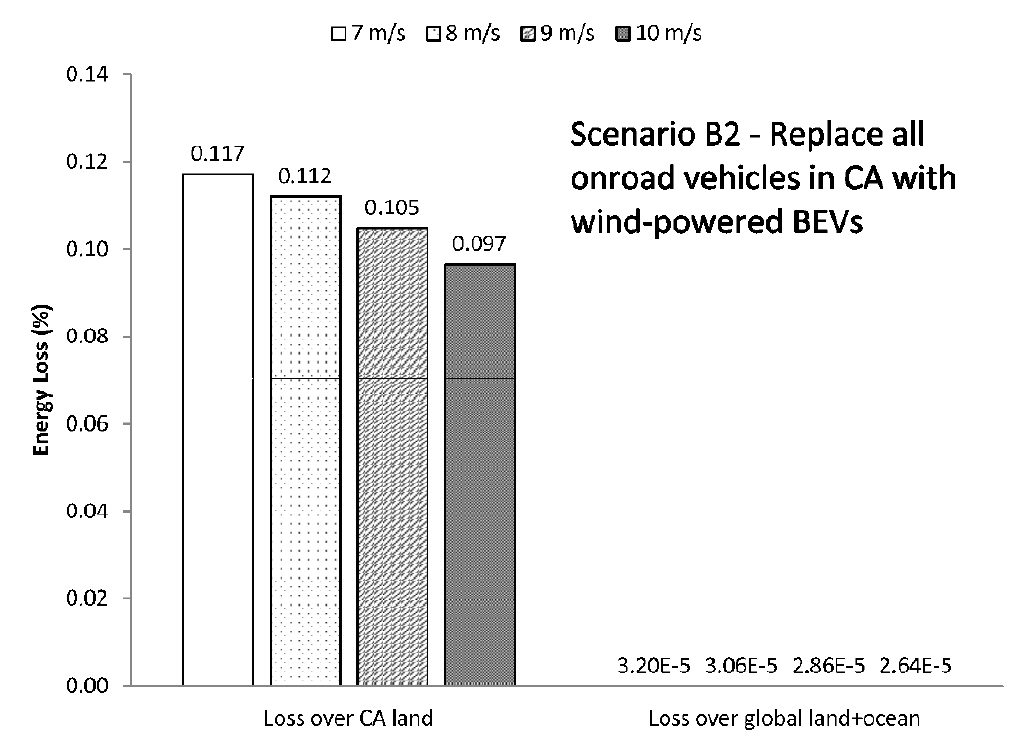
Figure 14. Energy loss (%) for Scenario B2, where all California onroad vehicles are replaced with WBEV. Here, the second set of bars represents the relative loss in the boundary layer just above California. The number of turbines for the different mean wind speeds are just roughly an order of magnitude less than that needed for the Scenario B1 and shown in Table